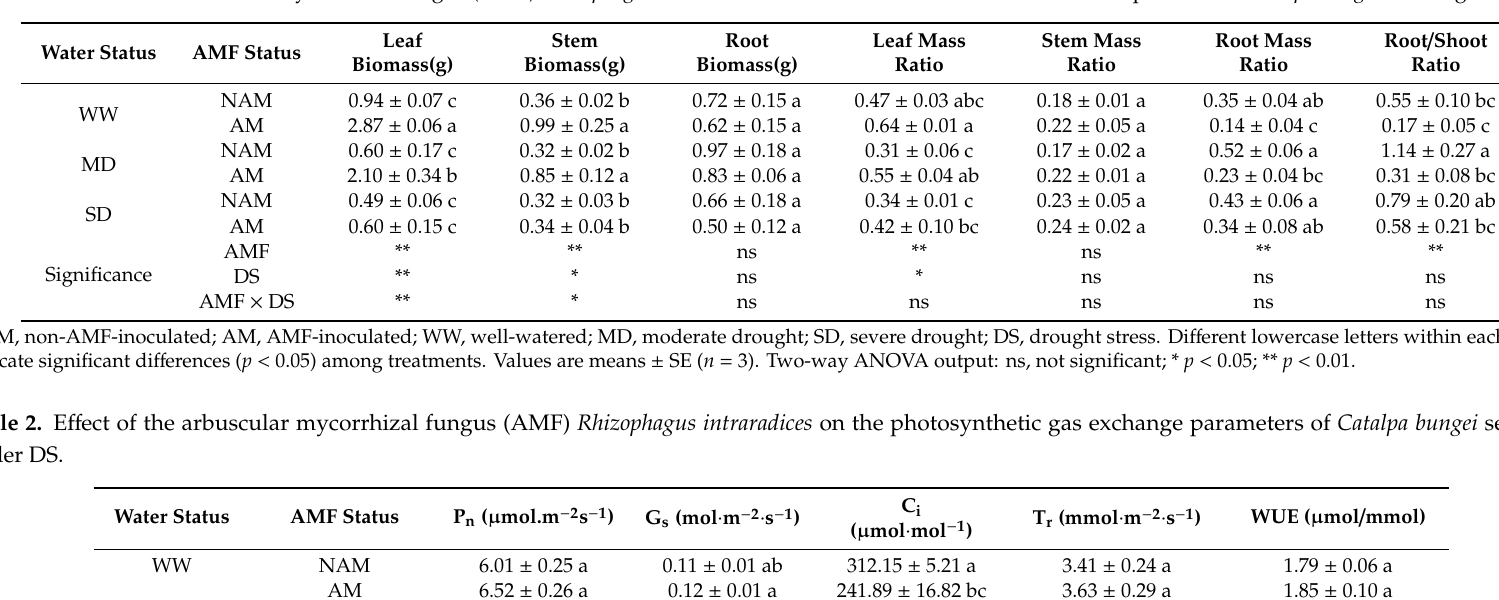
Table 1. E ff ect of the arbuscular mycorrhizal fungus (AMF) Rhizophagus intraradices on the biomass allocation in di ff erent parts of the Catalpa bungei seedlings under DS.